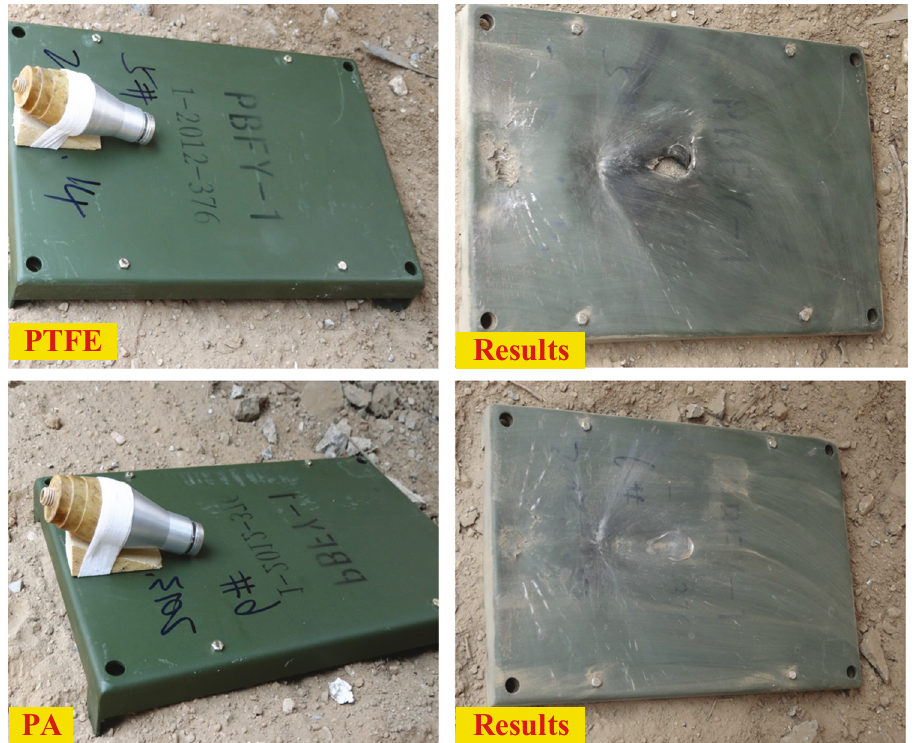
Figure 8: E ff ect of polymer jet impacting ERA obliquely.